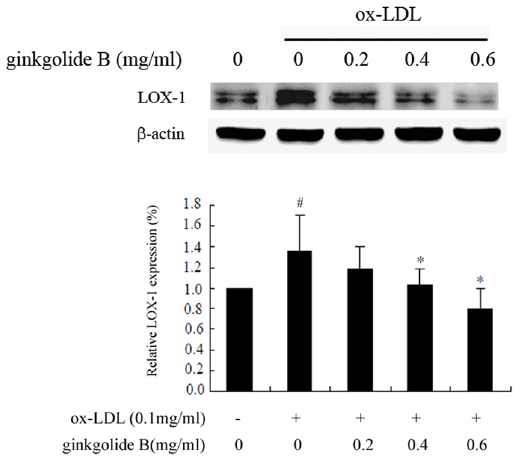
Figure 2. Ginkgolide B inhibits LOX-1 in ox-LDL-stimulated endothelial cells. The results were obtained from five independent experiments. # p , 0.05, compared with control; * p , 0.05, compared with ox-LDL-stimulated